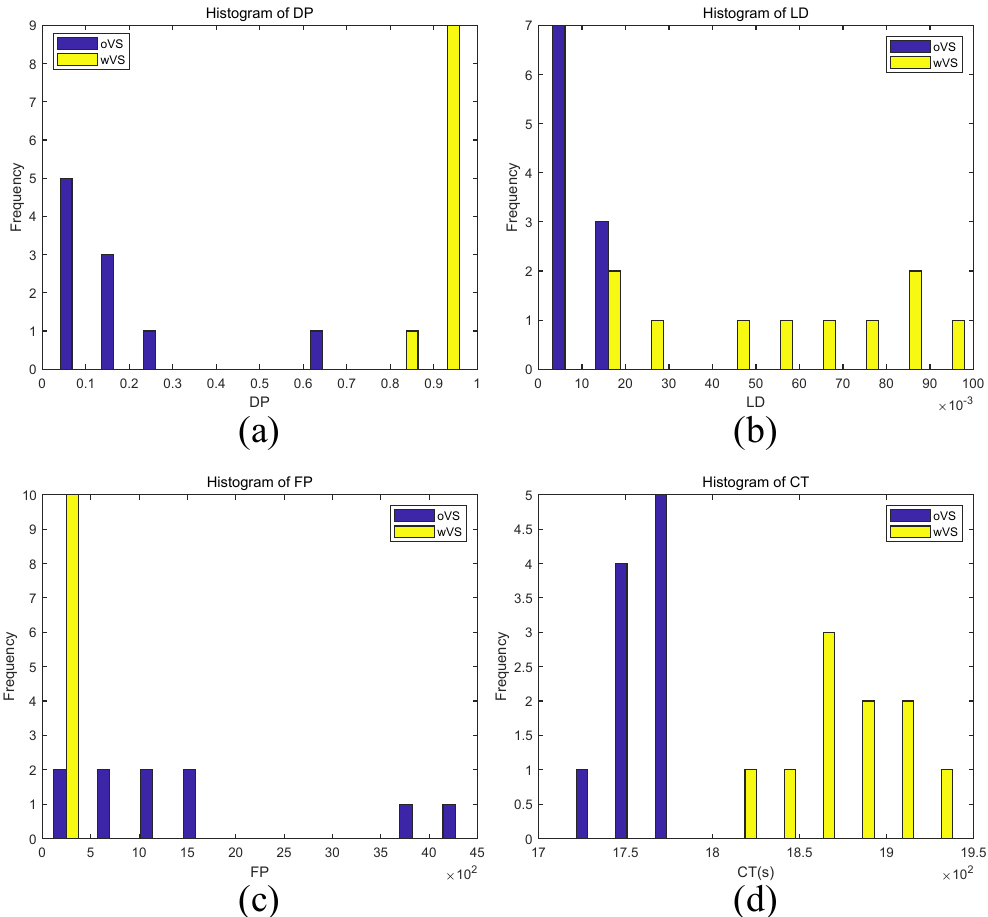
Figure 3. Histogram results of DP , LD , FP and CT of the proposed method with and without video stabilization: ( a ) DP histogram, ( b ) LD histogram, ( c ) FP histogram and ( d ) CT